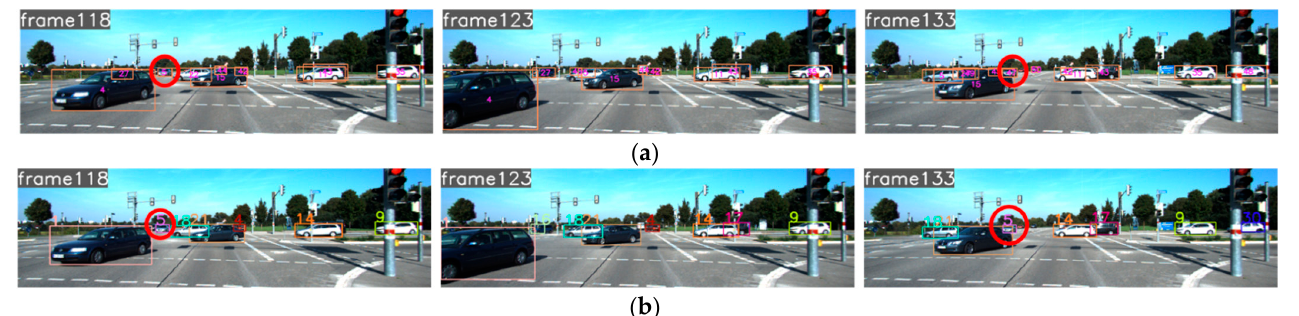
Figure 5. Qualitative comparison results between our method and PermaTrack [25] on the KITTI MOT testing sequence 0010 . Each tracked vehicle is represented in a unique ID. The red circles mark the objects severely or long-term occluded in subsequent frames. ( a ) Qualitative results on the KITTI MOT testing sequence 0010 of PermaTrack [25]. ( b ) Qualitative results on the KITTI MOT testing sequence 0010 of our method.